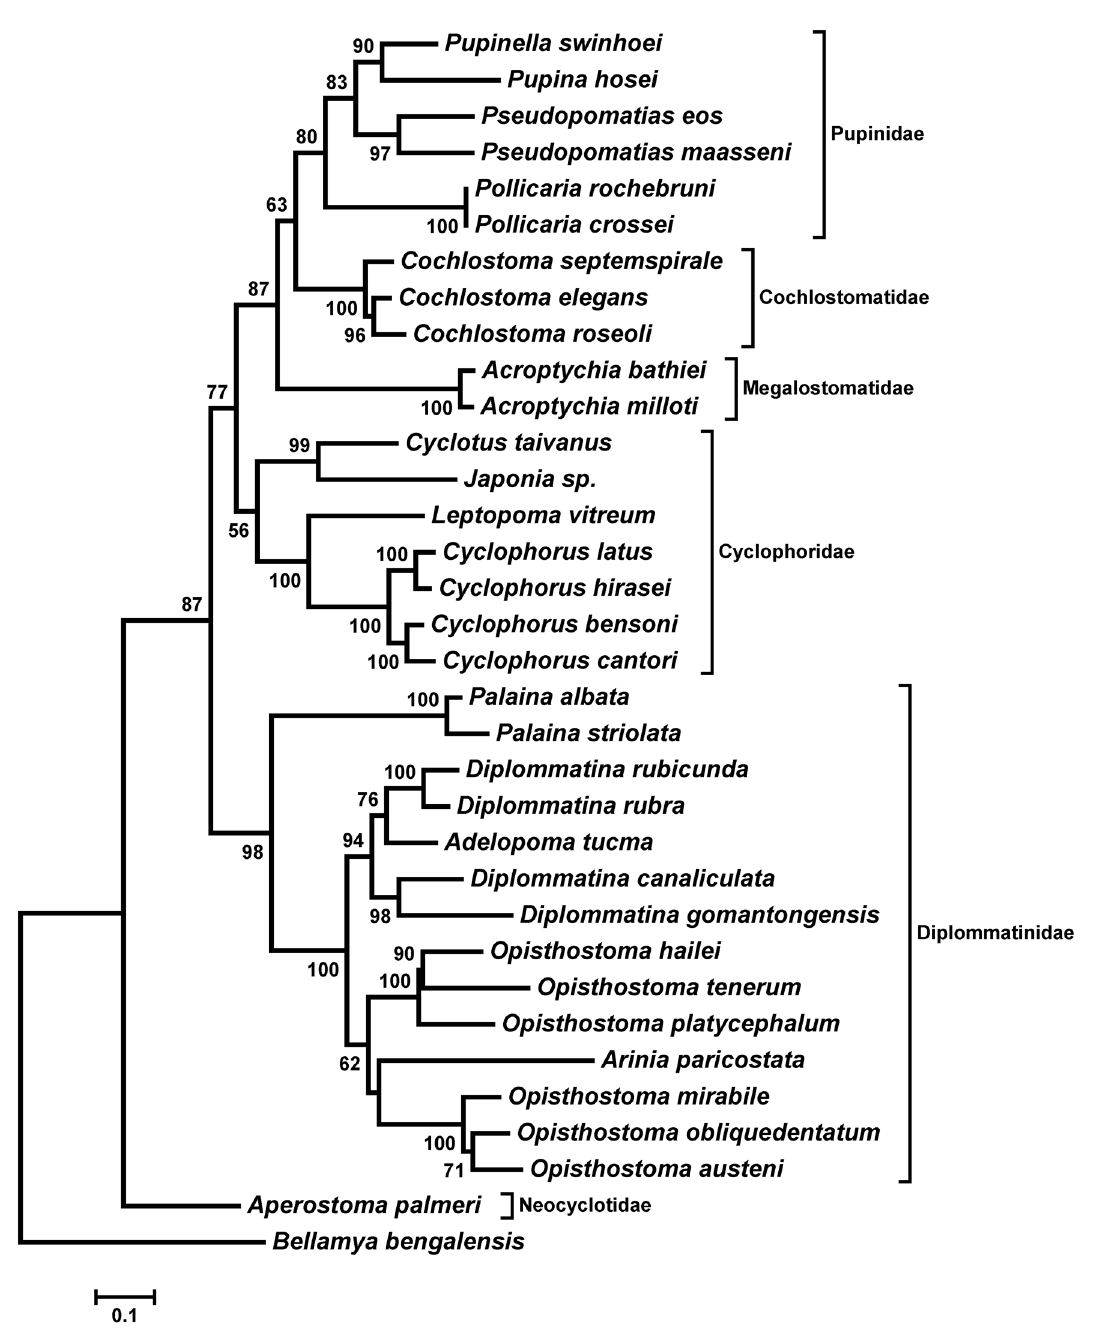
Figure 4. Phylogenetic tree (log likelihood= -17304.7519) based on three ribosomal genes (mt 16S, nuclear 18S and 28S) showing Pollicaria as sister to all other pupinid taxa. Values at branches are bootstrap values based on 10,000 ultrafast